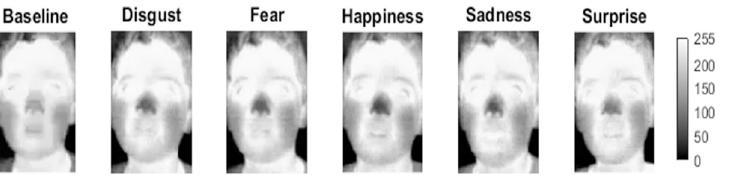
Fig 7. Representative frames of the emissivity decrease (in relation to baseline) in nose of a child during the emotions. Pixel intensity: